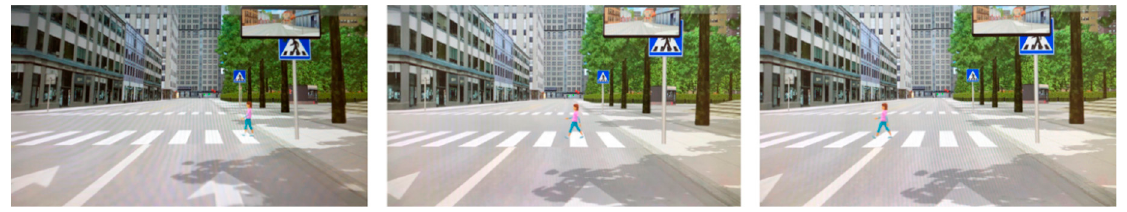
Figure 2. Crosswalk scenario in the driving simulator.